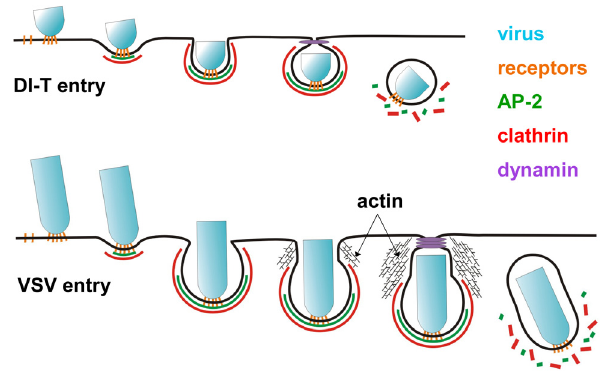
Figure 7. Model of DI-T and VSV entry. DI-T (above) and VSV (below) particles engage host cells through interactions between the viral surface glycoproteins and unknown cellular receptor moieties. Following attachment, both particle types undergo slow diffusion (diffusion coefficient , 5 6 10 2 11 cm 2 s 2 1 ) on the cell surface for an average of , 2 min. before being captured by a clathrin-coated pit. For DI-T, continued clathrin assembly drives complete particle envelopment by the plasma membrane and leads to virus endocytosis. In contrast, the presence of a VSV particle in a coated pit physically prevents complete membrane constriction by the clathrin machinery and causes clathrin assembly to halt prematurely. The force provided by actin polymerization then further remodels the plasma membrane and thereby encloses the virus particle in a partially clathrin-coated vesicle.